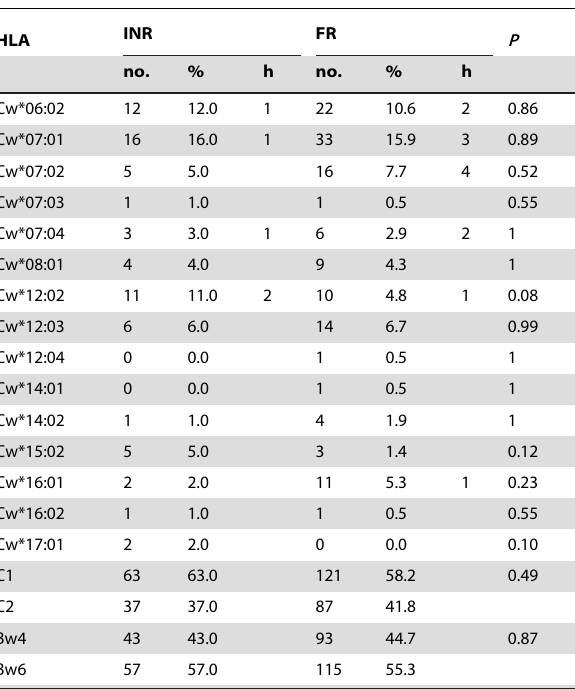
Table 3. Distribution of HLA B and C allele frequencies between immunological non responders (INR) and full responders